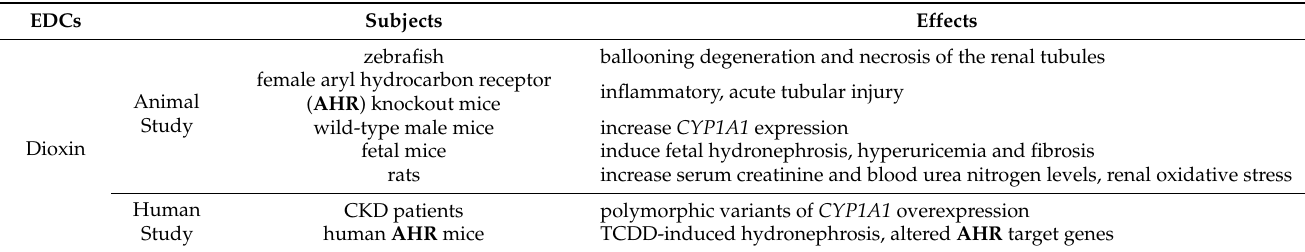
Table 1. Typical EDCs and kidney